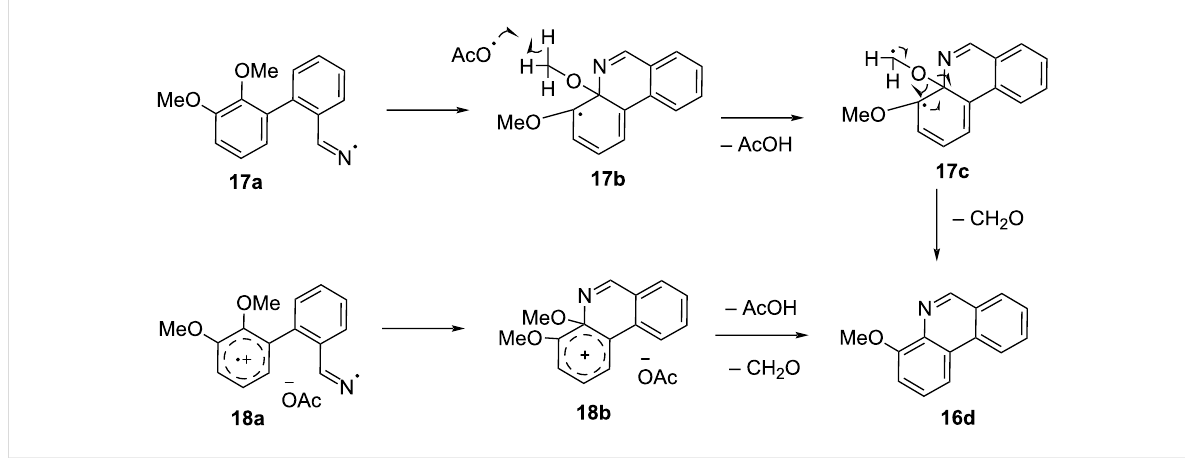
Figure 3: Two possible mechanistic routes and intermediates in the synthesis of phenanthridines.